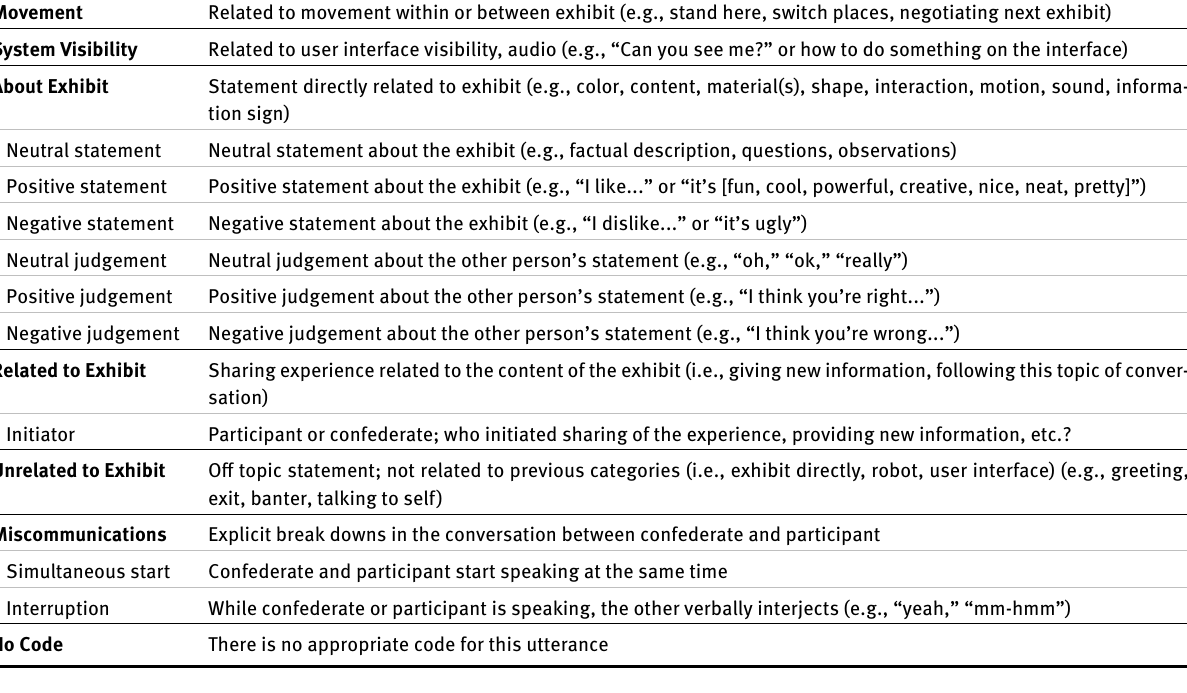
Table 1. Coding categories for conversation between confederate and participant during participant’s second gallery visit ( κ = 0.73 ) Movement System Visibility